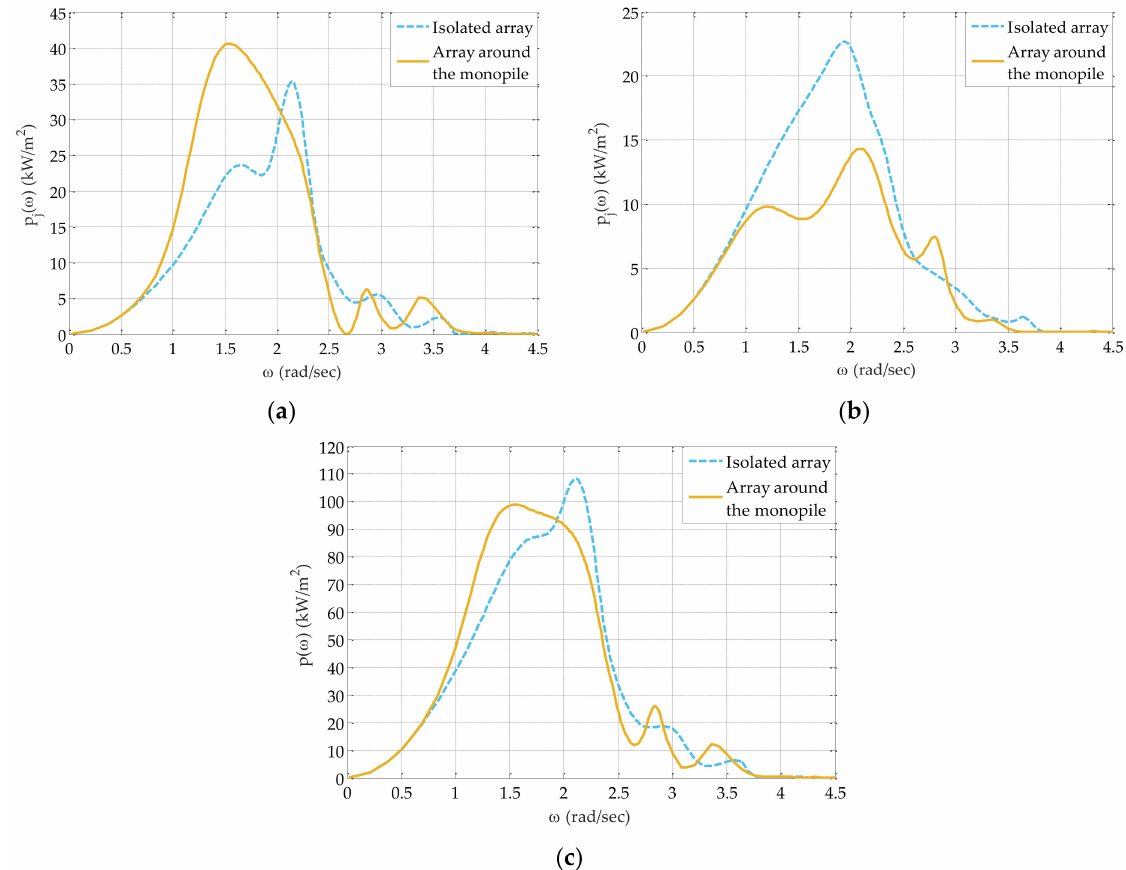
Figure 9. Comparisonof the mean power absorbed by the oblate spheroidal WECs with and without (isolated array) the monopile for β = 0 o and d net = 0.125 r 0 : ( a ) WEC1 and WEC4; ( b ) WEC2 and WEC3; ( c ) whole